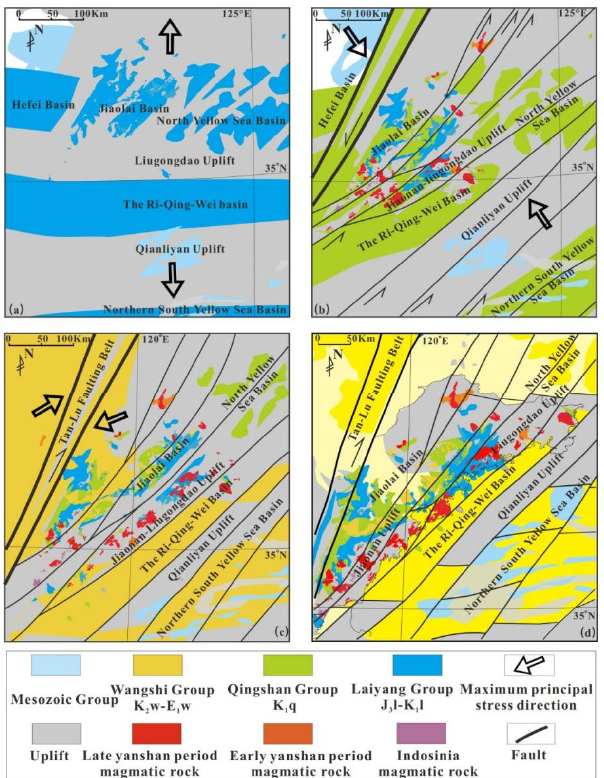
Figure 3. Tectonic outline map of the Ri − Qing − Wei basin and its surrounding area in different periods (modified from [13]): ( a ) 150 Ma; ( b ) 90 Ma; ( c ) 55 Ma; and ( d ) present.